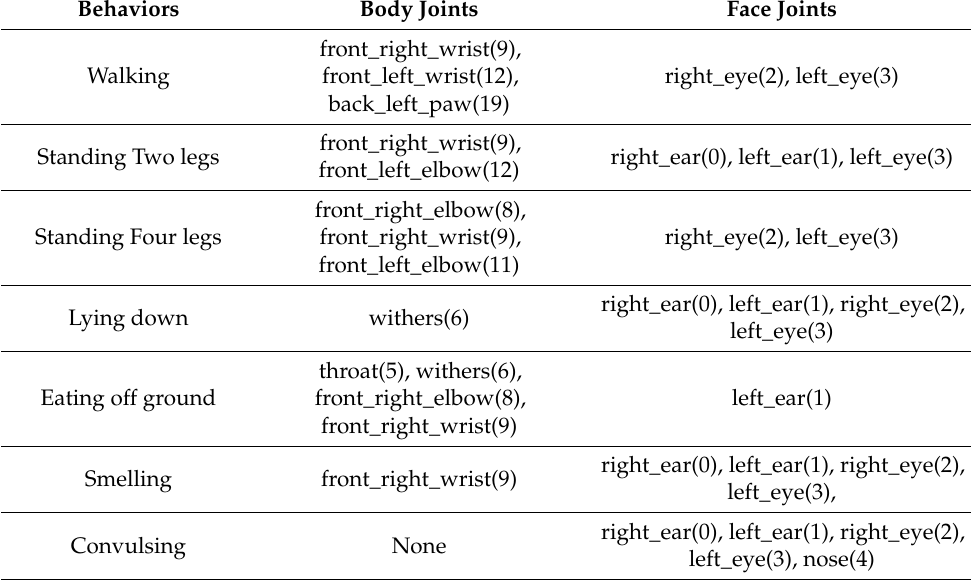
Table 6. Body and face joints detected for each dog behavior.